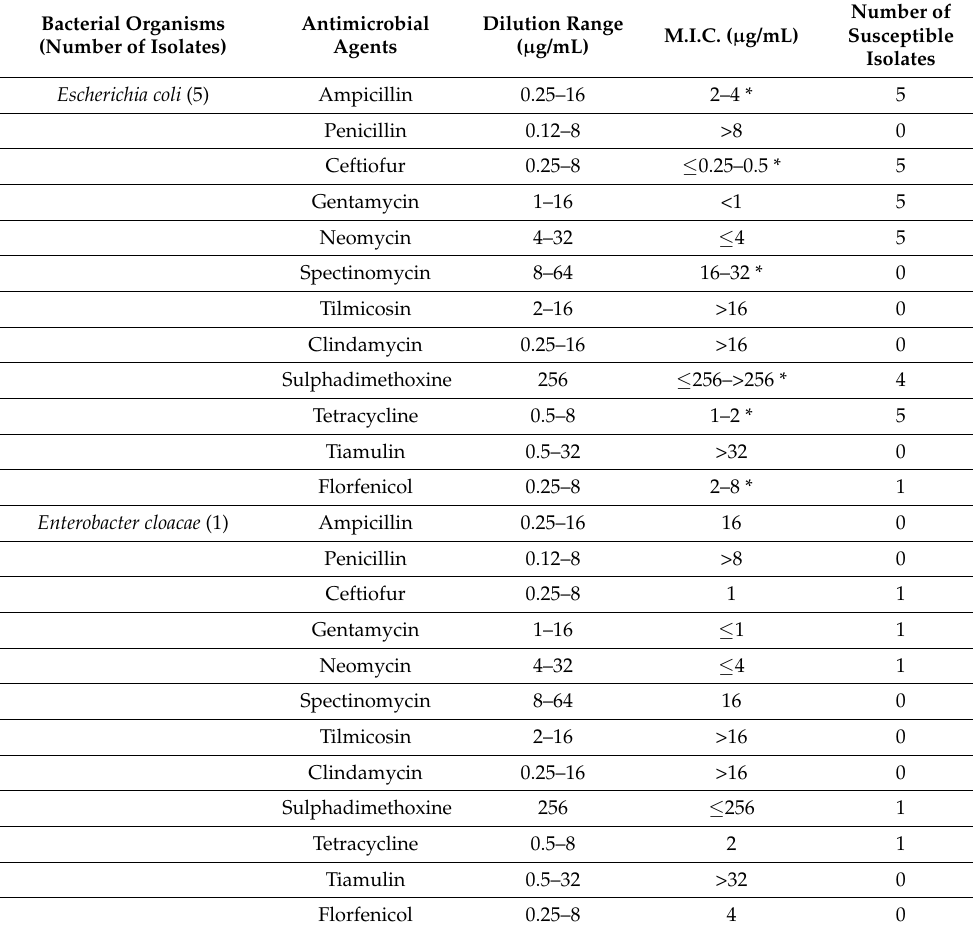
Table 1. A summary of the antimicrobial susceptibility test results for bacteria isolated from the plain pocketbook freshwater mussels inhabiting the Wildcat Creek in north-central Indiana, United States. Bacterial Organisms (Number of